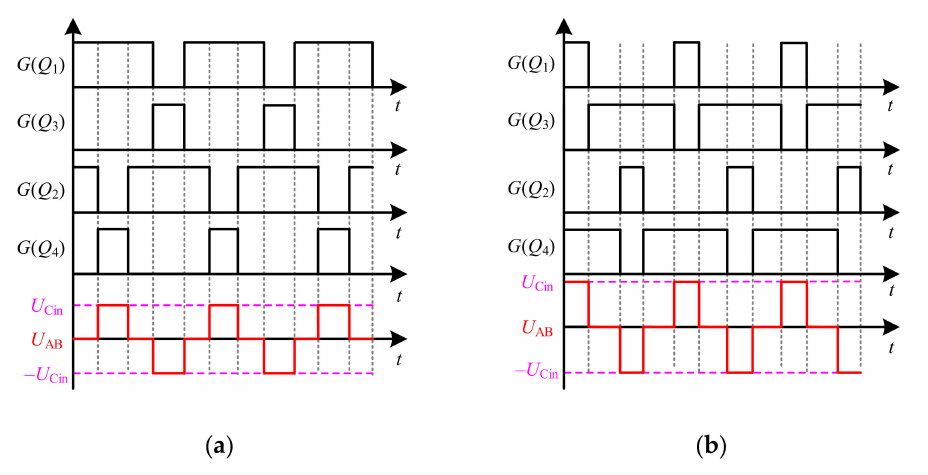
Figure 2. Waveforms of U AB under different duty cycles. ( a ) D ≤ 0.5; ( b ) D >